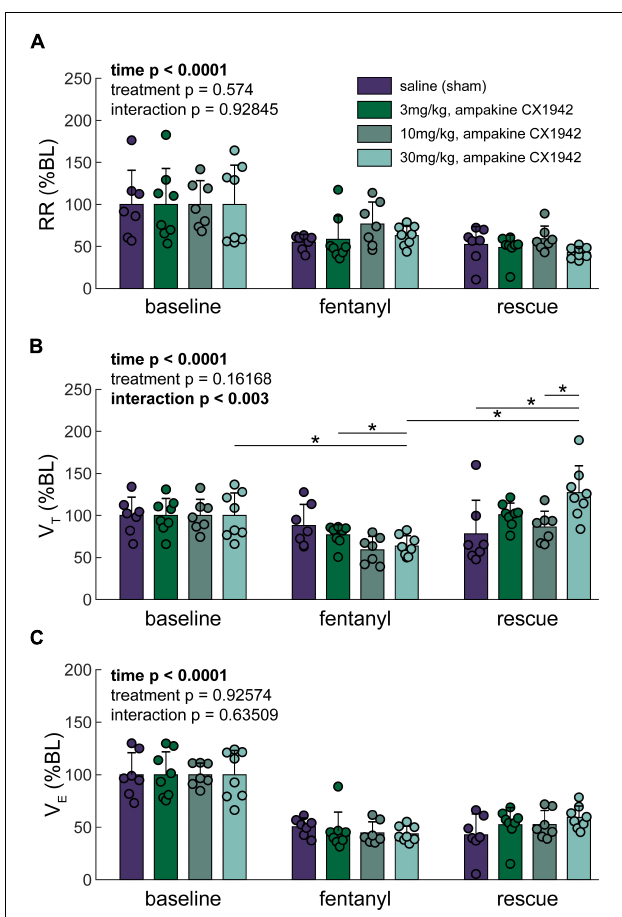
FIGURE 4 | Traditional ventilation metrics. (A) Respiratory rate (RR), (B) Tidal volume (V T ), and (C) Minute ventilation (V E ) expressed as a percentage of baseline. Two-way ANOVA. Post hoc comparisons (Tukey–Kramer) are shown (* p < 0.05) if the interaction p < 0.05; further only the comparisons within a time point across groups, or within a group but across time points are shown. n = 8 animals/treatment group; 32 animals stratified by treatment